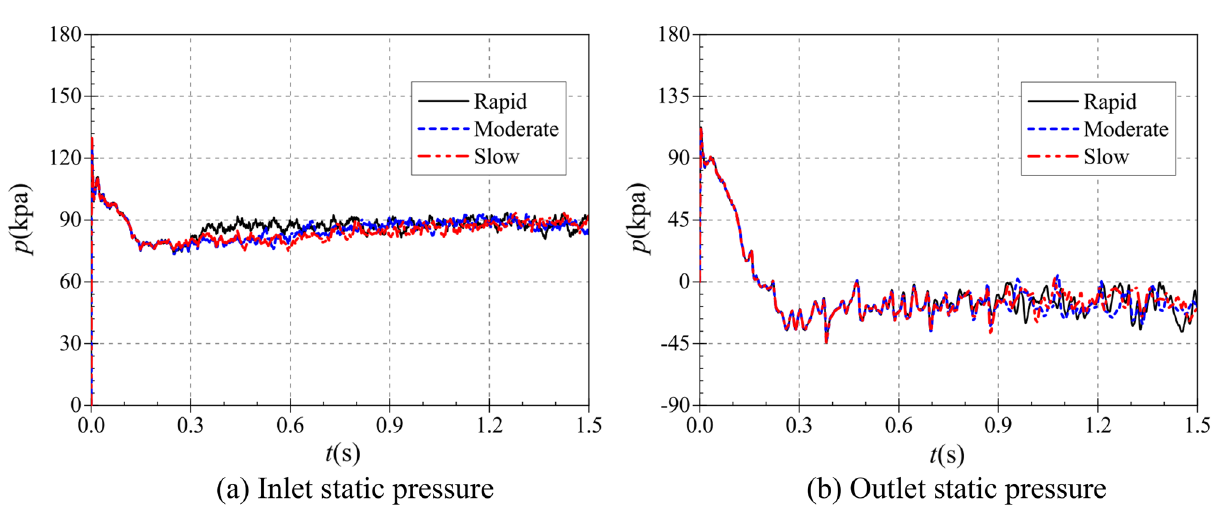
Figure 22. Valve inlet and outlet static pressure. ( a ) Inlet static pressure; ( b ) Outlet static pressure.